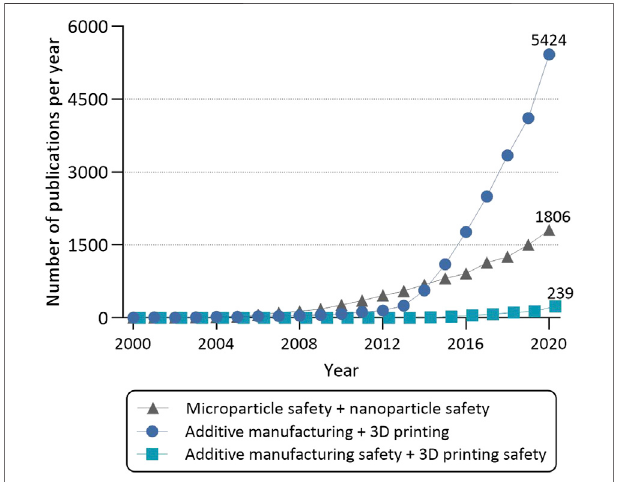
FIGURE 1 | Overview of the papers published over the last 20 years on the topics “ microparticle ” and “ nanoparticle safety, ” “ additive manufacturing ” and “ 3D printing, ” and “ additive manufacturing safety ” and “ 3D printing safety. ” All publications were found via PubMed literature search.